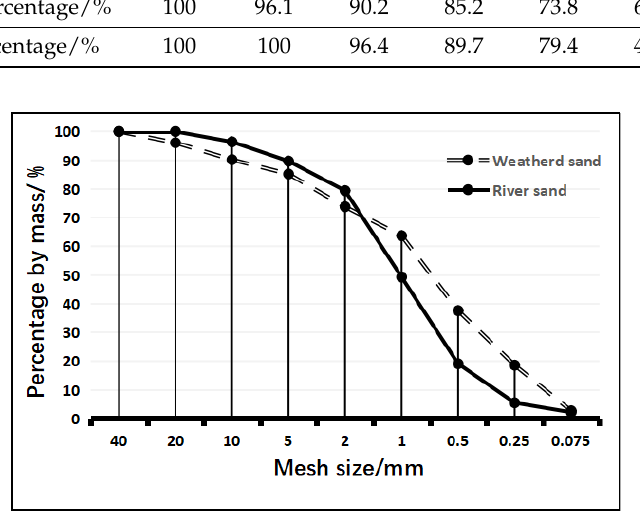
Figure 1. Particle analysis result plot.